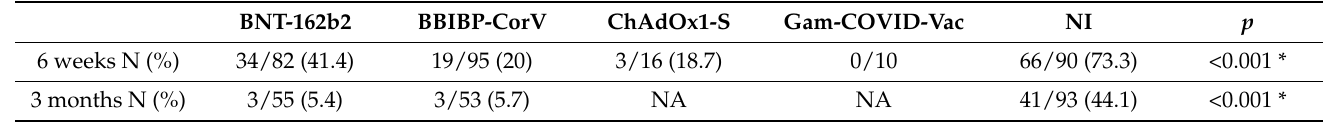
Table 2. Detection of specific IgM antibodies at 6 weeks and 3 months after vaccination and after COVID ‐ 19 infection. BNT ‐ 162b2